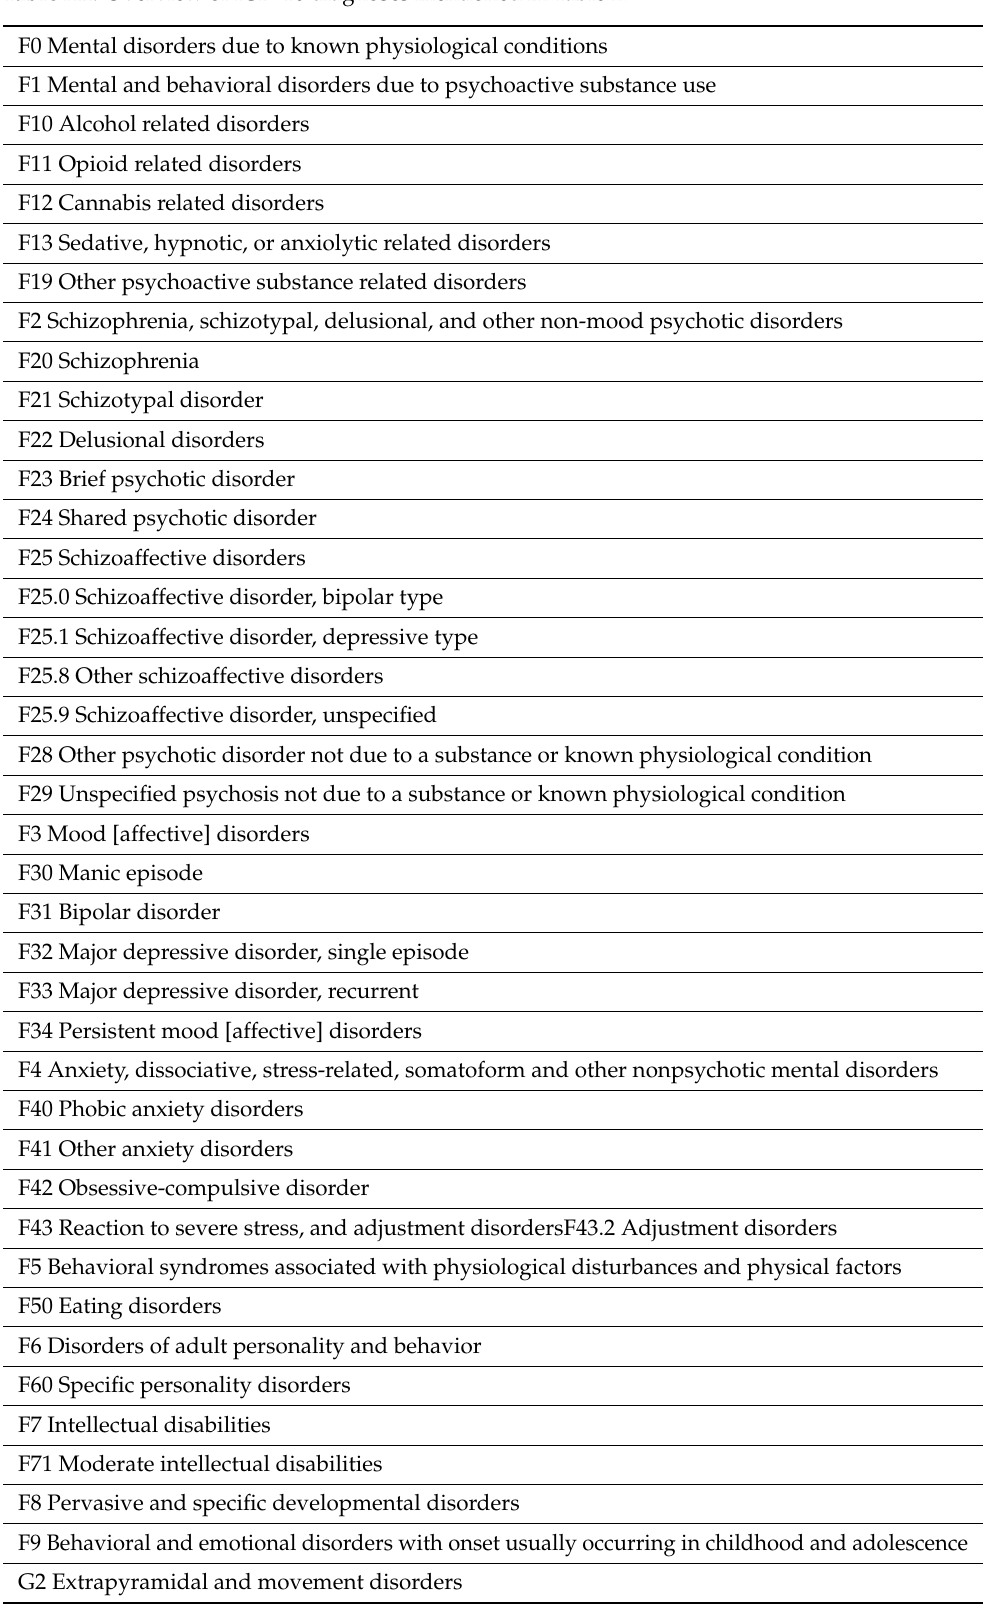
Table A1. Overview of ICD-10 diagnoses mentioned in Table